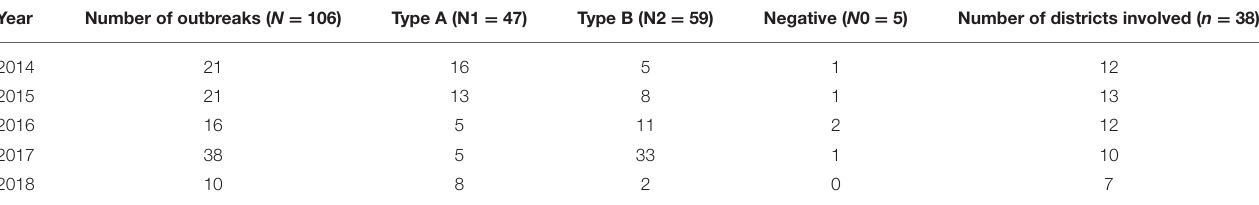
TABLE 1 | Cluster outbreaks of influenza-like illness cases. Year Number of outbreaks ( N = 106) Type A (N1 = 47) Type B (N2 = 59) Negative ( N 0 = 5) Number of districts involved ( n = 38)